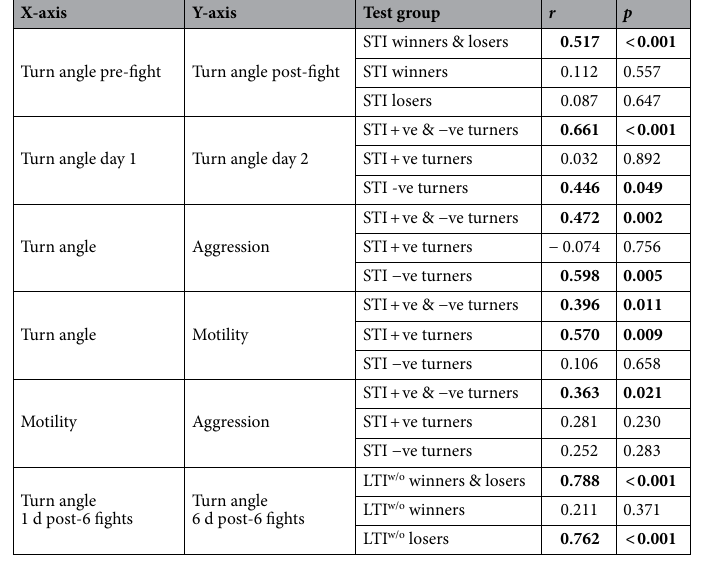
Table 1. Correlations between measured variables for selected test groups of individuals. r gives Pearson’s correlation coefficient and p the significance of difference. Statistically significant correlations are indicated in